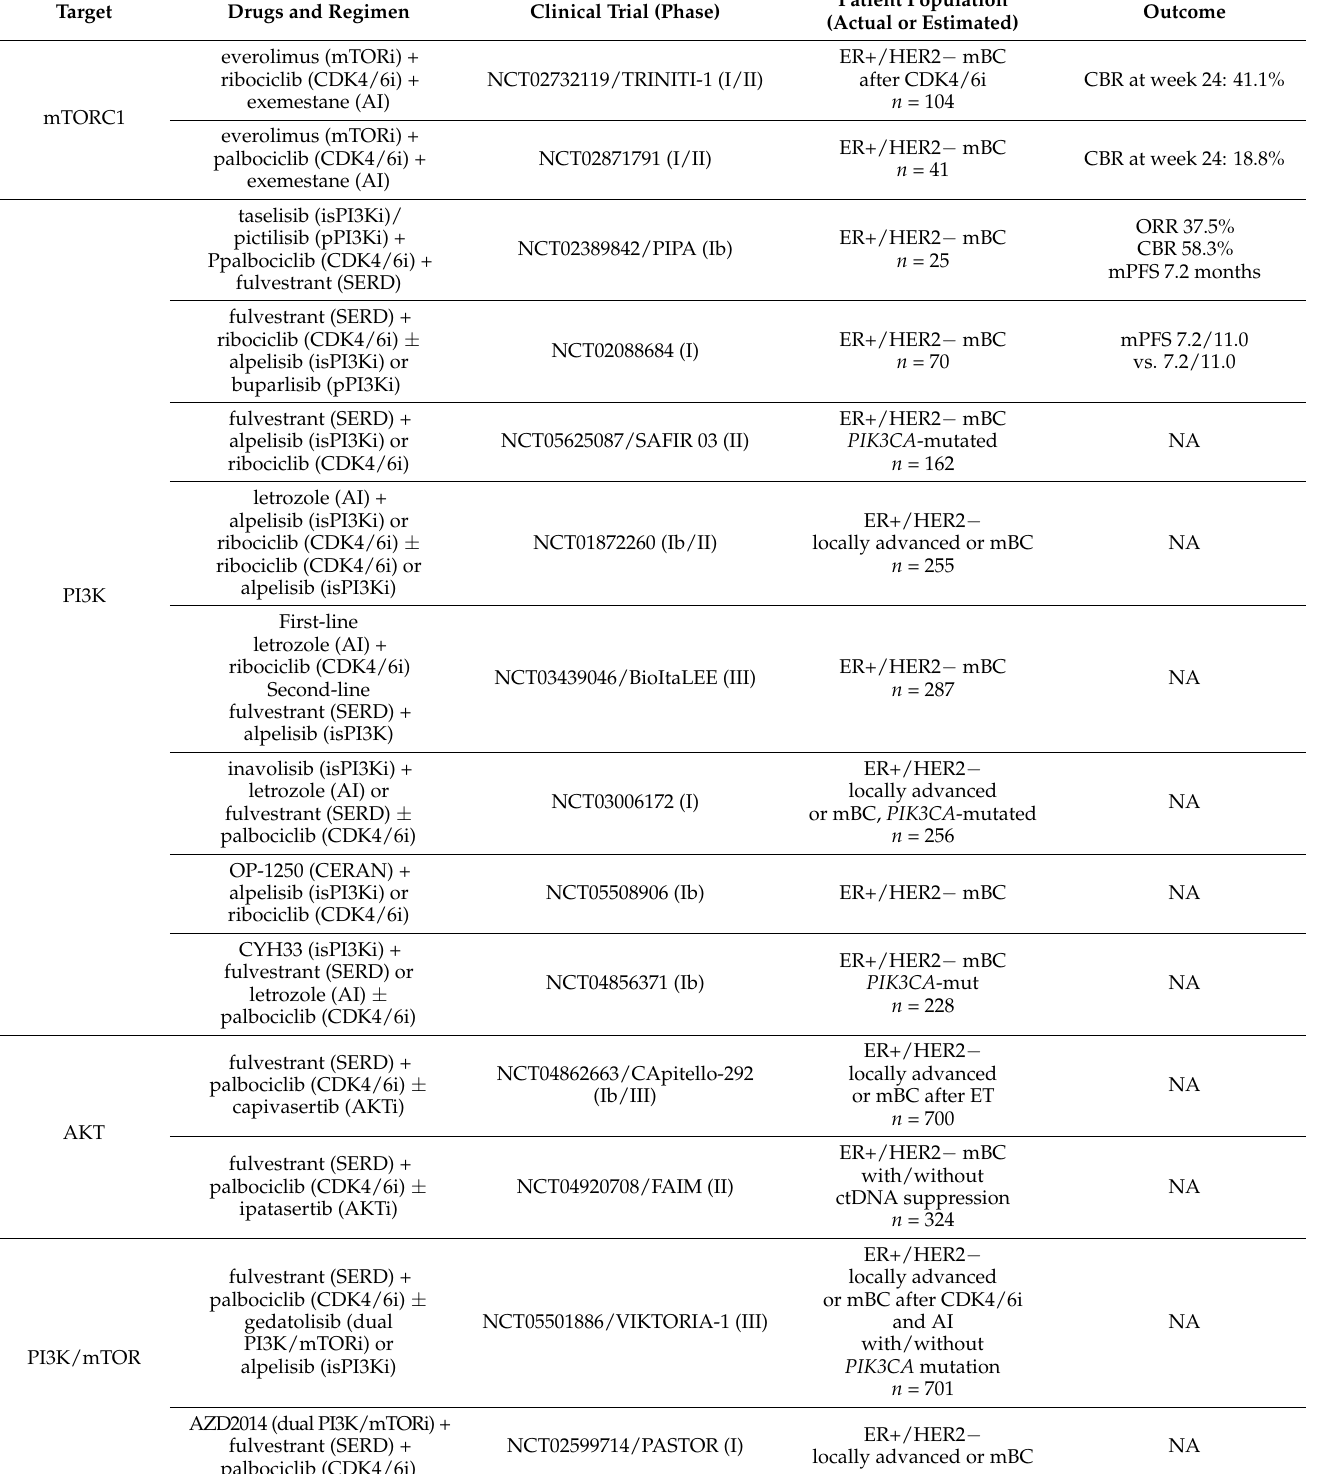
Table 2. Clinical trials testing triple and sequential double combinations with inhibitors of